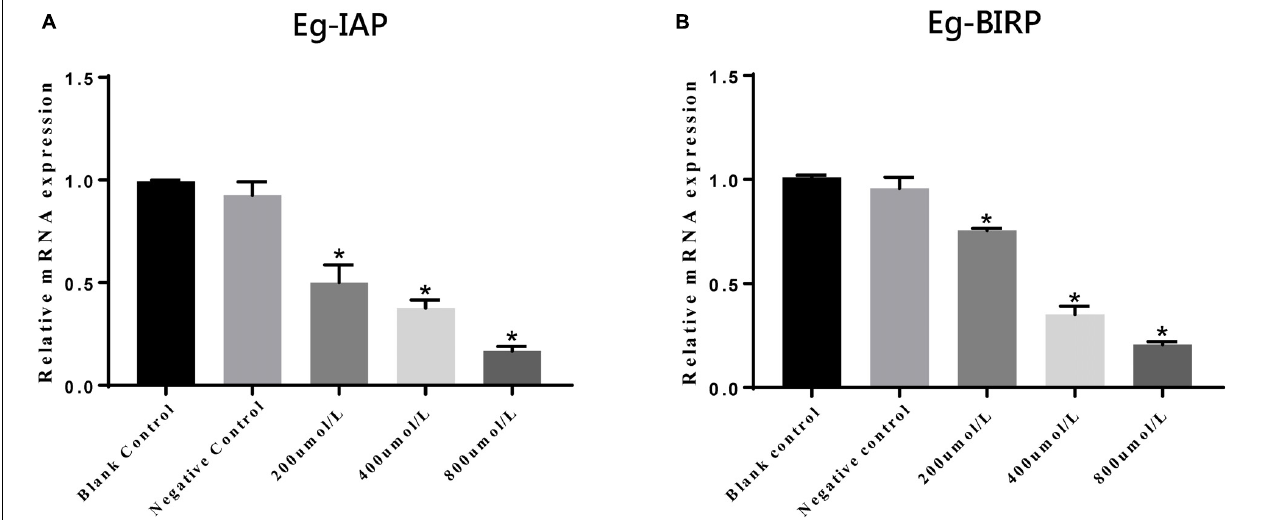
FIGURE 5 | Transcriptional differences of Eg-IAP (A) and Eg-BIRP (B) in PSCs incubated with LCL161 in vitro . Data are presented as the means ± SD ( n = 3). Statistically significant differences between blank control group and three dosing groups (* p < 0.05), and no significant differences between blank control group and negative control group ( p > 0.05) were determined using Student’s t